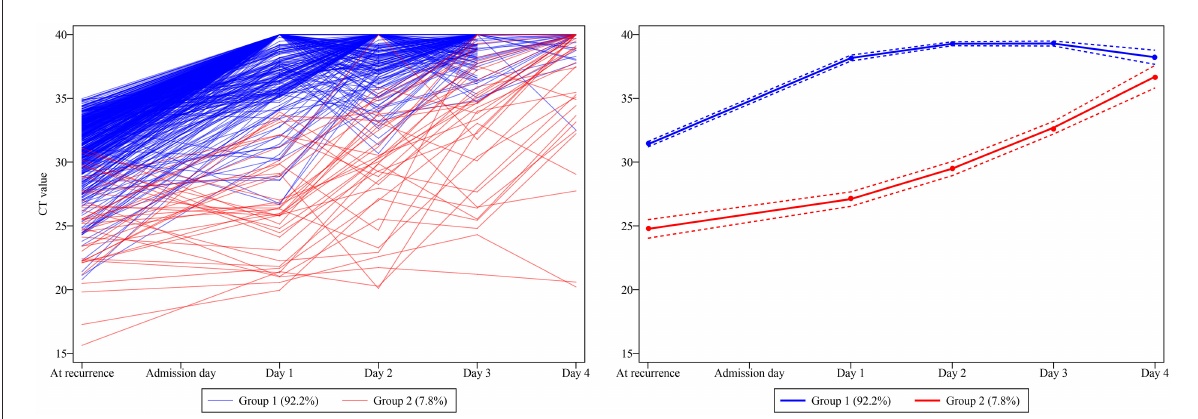
FIGURE2 The development of trajectory groups based on the dynamic Ct value traces. Two Ct value trajectories were distinguished, namely group 1 (92.2% [452 of 490]), demonstrates a higher baseline Ct value which promptly and persistently turns to negative from day 1 after admission; and group 2 (7.8% [38 of 490]), demonstrates a lower baseline Ct value which steadily and wavily climbs back to normal after day